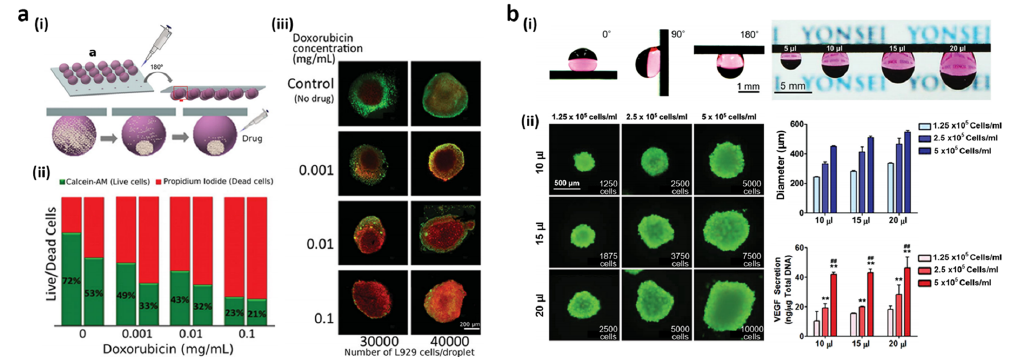
Figure 9. ( a ) ( i ) Hanging drop culture on the indentation ‐ patterned superhydrophobic surface; ( ii ) Live (green)/dead (red) cell ratios 24 h after the addition of various doxorubicin concentrations for densities of 30,000 (left bar) and 40,000 (right bar) cells/droplet; ( iii ) Fluorescent images of L929 spheroids in the presence of doxorubicin ( ii ); ( b ) ( i ) Culture medium droplets adhered on the H 2 ‐ exposed Pd ‐ coated Si NWs for different tile angle (0°, 90°, and 180°) and medium volumes (5, 10, 15 and 20 μ L); ( ii ) Live/dead cell staining, size distribution, and vascular endothelial growth factor (VEGF) protein secretion from spheroids after 4 days of culture at various cell densities and medium volumes. Reproduced from [18,136] with permission by John Wiley and Sons, Copyright 2014.